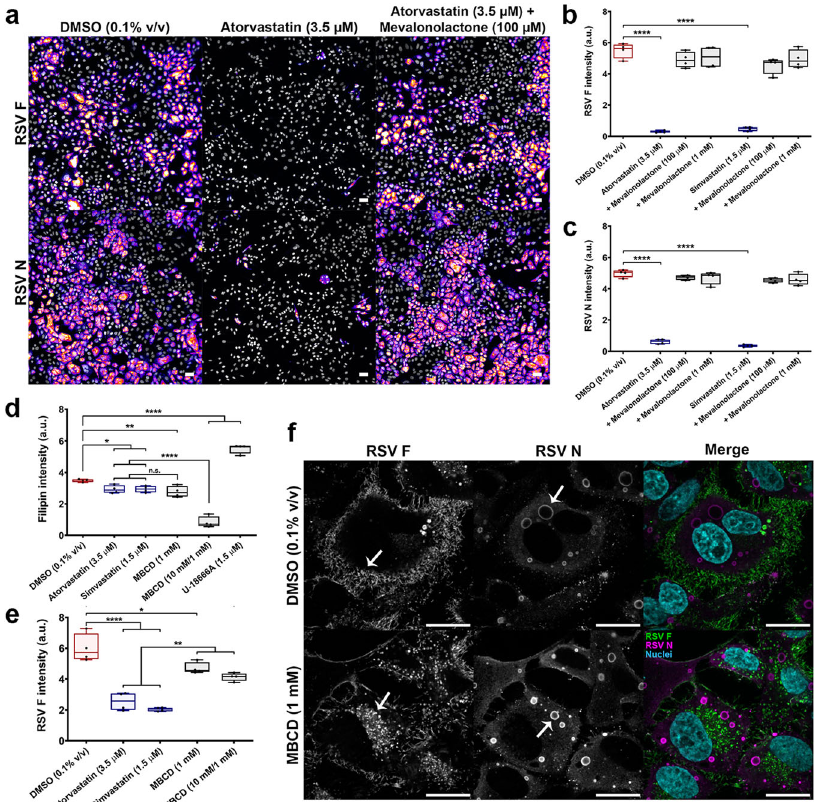
Fig. 4 The antiviral effects of statins are mediated by the mevalonate pathway. To con fi rm that the antiviral effects of statins were due to inhibition of the mevalonate pathway, RSV-infected cells were co-treated 2 h post-viral exposure with atorvastatin and mevalonolactone (a membrane-permeable ester of mevalonate). a Representative images of RSV A2 (MOI 0.5)-infected HEp-2 cells acquired 48 h p.i., stained for the F and N proteins. Atorvastatin treatment signi fi cantly inhibits RSV, whereas co-treatment with mevalonolactone fully rescues infection. Scale bars = 100 µ m. b, c Quanti fi cation of F and N immuno fl uorescence 48 h p.i. Exogenous addition of mevalonolactone (100.0 µ M or 1.0 mM) restores RSV infection to DMSO baseline in the presence of either atorvastatin (3.5 µ M) or simvastatin (1.5 µ M) ( n = 4 independent measurements). d – f Mevalonate is converted to several downstream metabolites, including cholesterol. To probe cholesterol-speci fi c effects on RSV infection, HEp-2 cells were depleted of cholesterol using MBCD. d Low- dose MBCD (1.0 mM) matched the level of cholesterol depletion by statins, whereas acute pre-treatment with high-dose MBCD (10.0 mM) caused high levels of cholesterol depletion. U-18666A was included as a control and induced intracellular accumulation of cholesterol. Total cholesterol was quanti fi ed by fi lipin III fl uorescence ( n = 4 independent measurements). e Both low and high cholesterol depletion by 1.0 and 10.0 mM MBCD had a lesser inhibitory effect on RSV compared to statins, as quanti fi ed by F protein intensity ( n = 4 independent measurements). f High-resolution confocal microscopy of the F (green) and N (magenta) proteins in RSV A2-infected HEp-2 cells (MOI 0.5). Cholesterol depletion by MBCD (1.0 mM) disrupts F protein surface localization (as indicated by the arrows). The N protein was expressed and localized to cytoplasmic viral inclusions. Scale bars = 20 µ m. Box plots indicate the complete range (whiskers), interquartile range (box), and median (line) of measurements. The y -axis of each graph denotes fl uorescent intensity normalized to total nuclear count (a.u. arbitrary units). Statistics were calculated by a one-way ANOVA with a Dunnett ’ s multiple comparisons post hoc test (n.s. non-signi fi cant, * P < 0.05, ** P < 0.01, **** P <